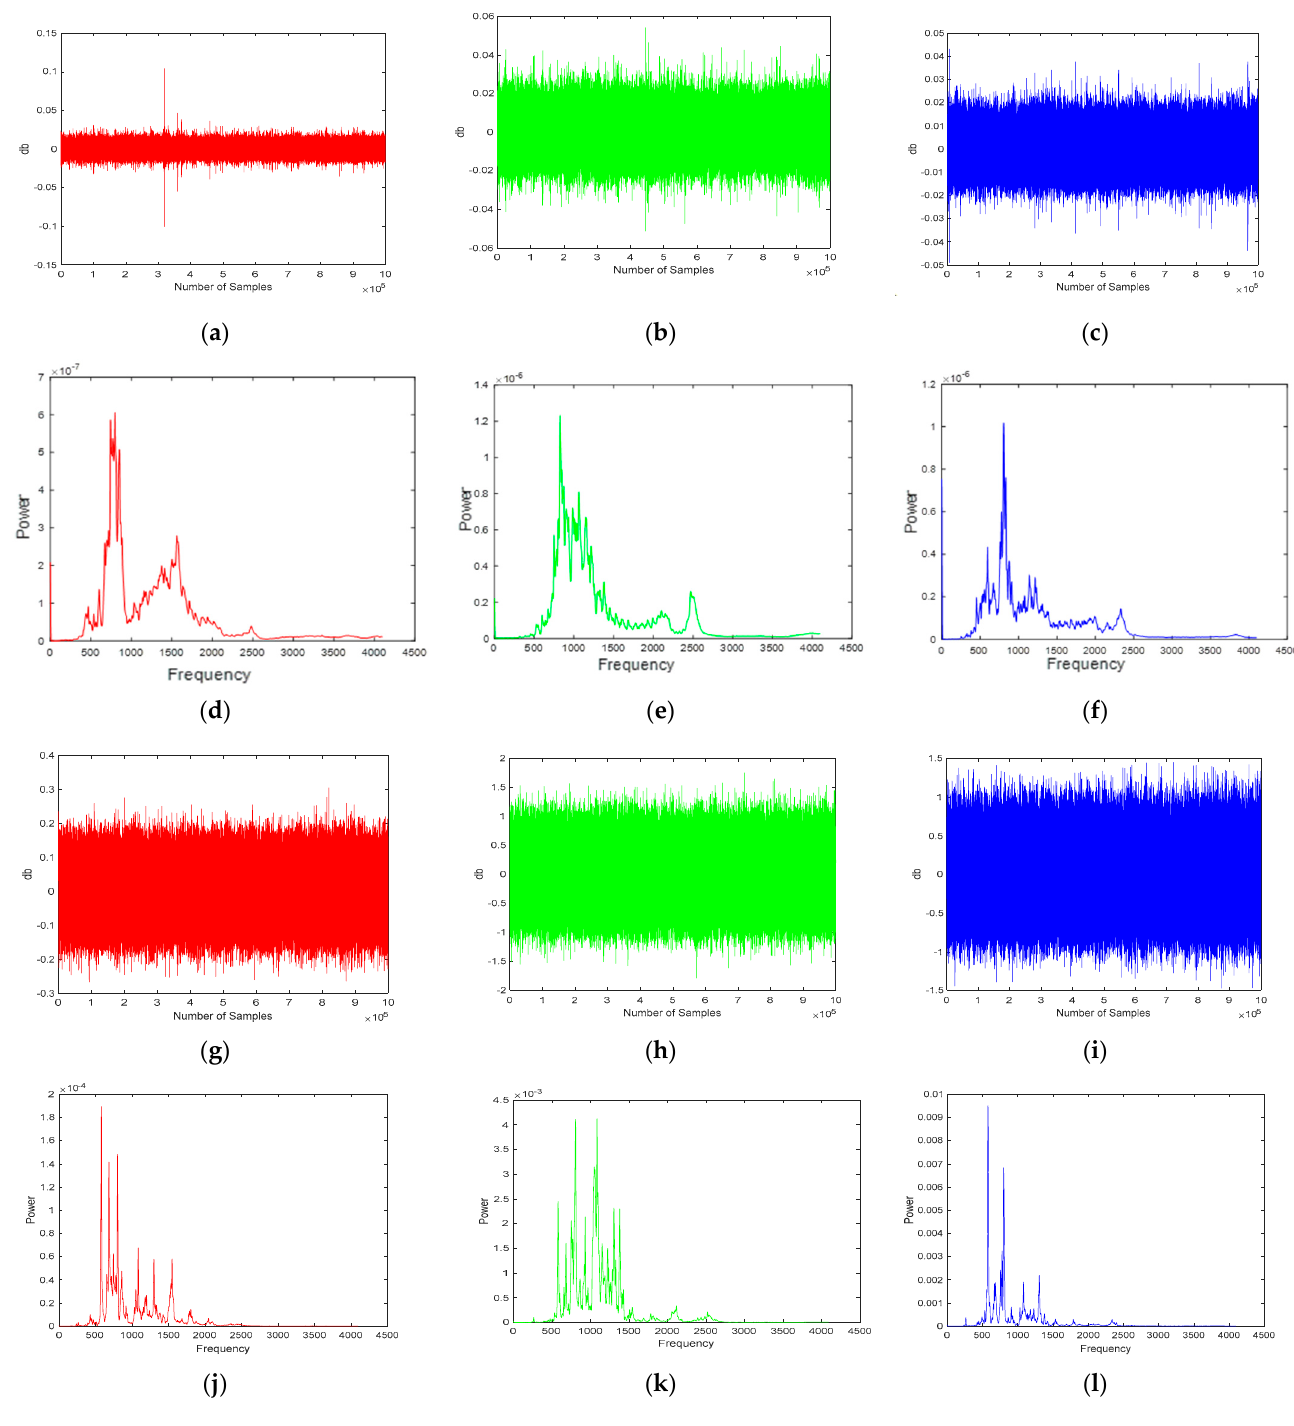
Figure 3. Amplitude and spectral power of the AE signals obtained from the pipeline under normal and leak operating conditions. ( a – c ) AE signal under normal operating conditions. ( d – f ) Power spectrum under normal operating conditions. ( g – i ) AE signal under pipeline leak operating conditions. ( j – l ) Power spectrum under pipeline leak operating conditions. ( a ) Channel-1 Time Response No-leakage. ( b ) Channel-2 Time Response No-leakage. ( c ) Channel-3 Time Response No-leakage. ( d ) Channel-1 Frequency Response No-leakage. ( e ) Channel-2 Frequency Response